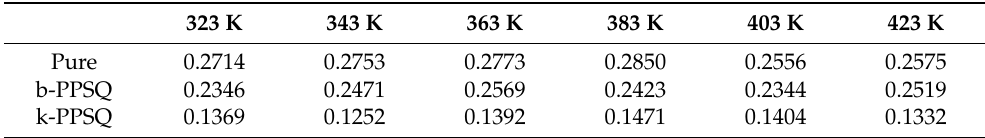
Table 1. Poisson’s ratio of the two blending models at different temperatures.